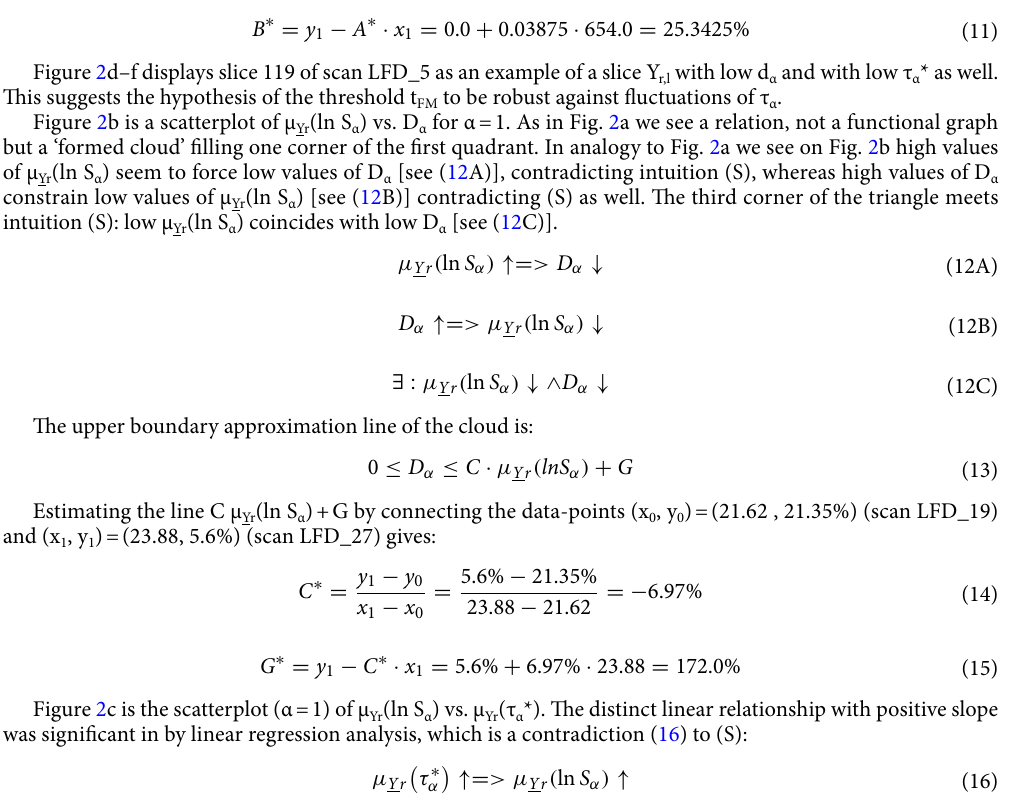
The deviations (8C), (12A), (12B), (16) from (S) were investigated, using the simulated CT images (Y A,r ) r=1,…,R and (Y B,r ) r=1,…,R (see Fig. 3a, b). Figure 3c shows a scatterplot of τ α+ vs. τ α * with ranges [0, 6000] on the X- and on the Y-axis for sample Y A,r . The matching of τ α+ and τ α * is almost perfect here, becoming slightly weaker in the region near (0,0). Zooming in on a range of [0, 400] for τ α+ we notice strong deviations of the estimator values τ α * in Fig. 3d. Note that the range of our sample Ψ’s mean separabilities μ Yr (τ α *) is [0, 600]: The correlation of τ α+ and τ α * of our sample Ψ would have to be estimated from the zoomed in representation in Fig. 3d rather than from the diagram in Fig. 3c. The correlation of τ α+ and τ α * refutes the objection to the positive correlation μ Yr (τ* α ) − μ Yr (lnS α ) in Fig. 2c: “Maybe there is a negative correlation in the analogous μ Yr (τ + α ) − μ Yr (lnS α ) diagram, which cannot be detected as τ + α is not accessible for our real-world-sample Ψ, but the μ Yr (τ* α ) − μ Yr (lnS α ) diagram shows a positive correlation caused by a flaw of CFES generating a locally negative correlation between τ α+ and τ α *?” Despite the noise in Fig. 2c there the images Y A,r (square marks). The partial graph over τ α *-range [1150, 3000] corresponds with (S): Rising τ α * is correlated with falling ln S α and vice